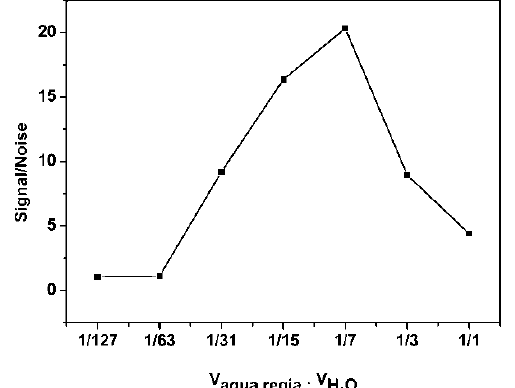
Figure 3. Signal/noise ratio versus the concentration of aqua regia. Experimental conditions: 20 µL gold nanoparticles (15 nm) was dissolved in 200 µL of different concentrations of aqua regia , then 200 µL H O, 75 µL 0.1 M sodium tartrate and 1.0 M 2